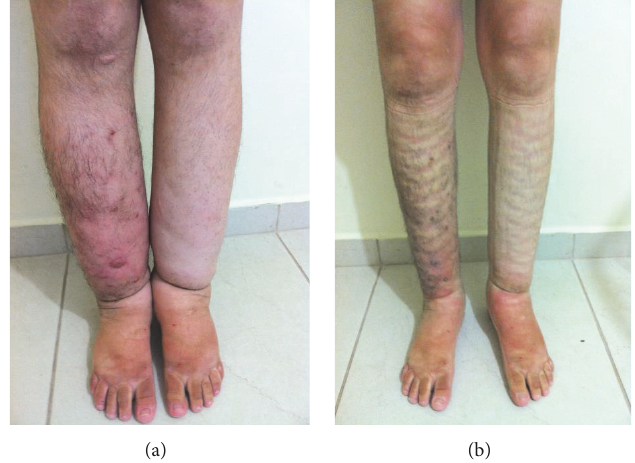
Figure 2: (a) and (b) show initial treatment and treatment after 5 days in primary